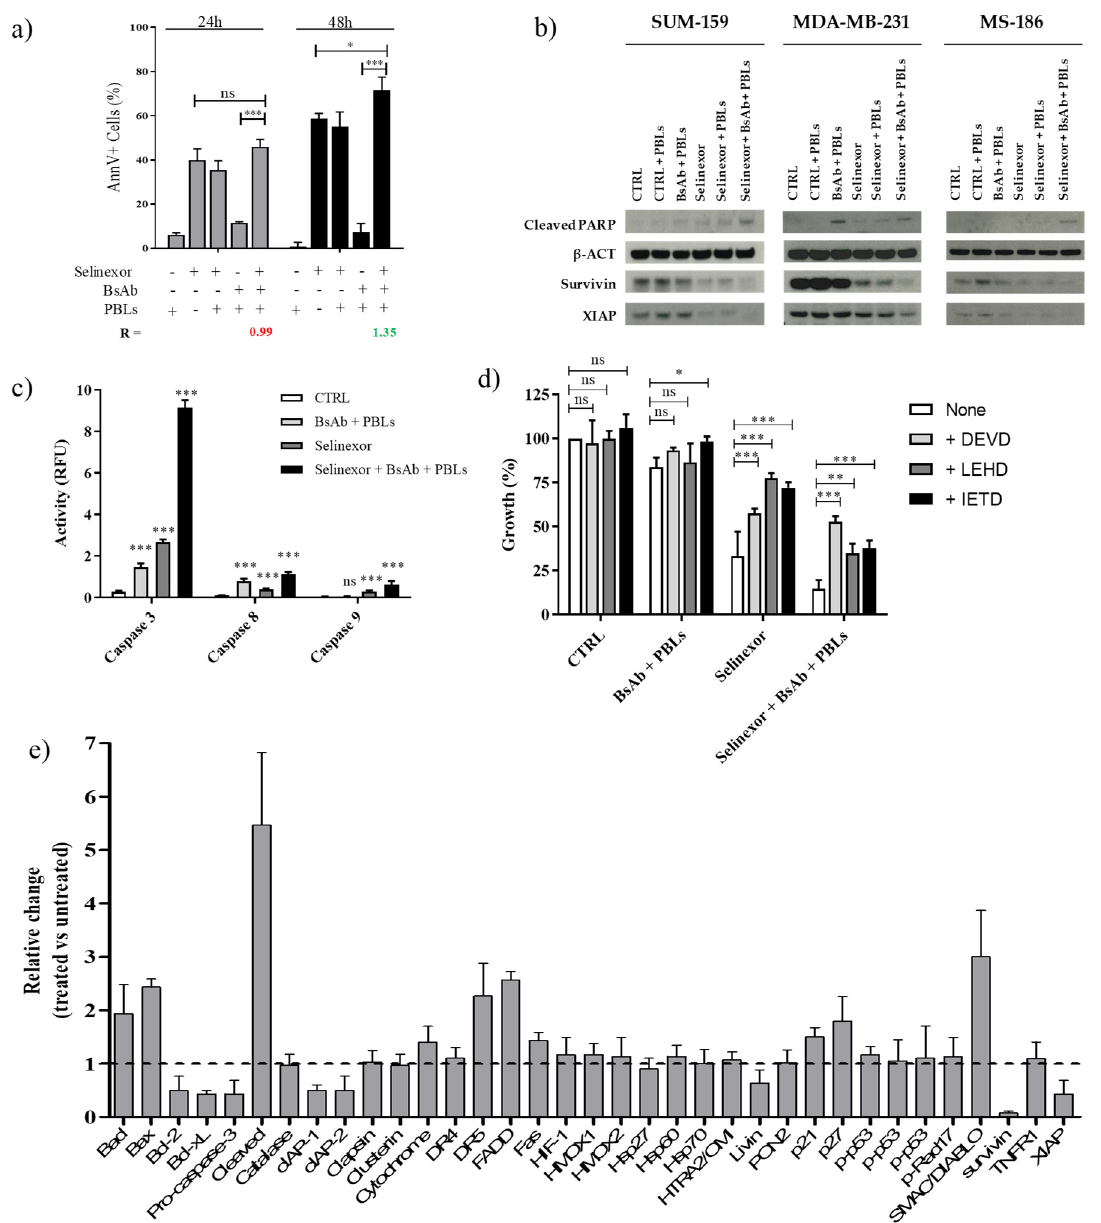
Figure 4. Induction of apoptosis in TNBC cells treated with the selinexor and TRAIL-R2xCD3 BsAb + PBL combination. ( a ) Induction of apoptosis was evaluated by flow cytometry as the presence of annexin V-positive cells (annexin V + / propidium iodide (PI) – plus annexin V + / PI + cells). Cells were exposed for 24 h to 0.1 µ M selinexor followed by 24 h and 48 h treatment with 0.5 µ g / mL TRAIL-R2xCD3 BsAb + PBLs (E:T ratio = 5:1). Data represent mean ± SD of at least three independent experiments. *** p < 0.001; * p < 0.05; ns, not significant. ( b ) Representative western immunoblotting showing the e ff ect induced by individual and combined treatments on the expression of cleaved PARP, survivin, and XIAP. ( c ) Assessment of caspase-3, caspase-9, and caspase-8 catalytic activity in SUM-159 cells exposed to 0.1 µ M selinexor and 0.5 µ g / mL TRAIL-R2xCD3 BsAb + PBLs (E:T ratio = 5:1), alone or in combination. Data are expressed as relative fluorescence units and bars represent the mean values ± SD of at least three independent experiments. *** p < 0.001; ns, not significant versus untreated. ( d ) Cytotoxic e ff ect of selinexor and TRAIL-R2xCD3 BsAb + PBLs, alone and in combination, in the presence of specific inhibitors of caspase-9, -3, and -8 (z-LEHD-fmk, z-DEVD-fmk, and z-IETD-fmk, respectively). Data are expressed as percentage values of growth in treated cells compared with cells exposed to 0.01% DMSO (CTRL), and represent mean values ± SD of at least three independent experiments. *** p < 0.001; ** p < 0.01; * p < 0.05; ns, not significant. ( e ) Relative levels of apoptosis-related proteins in